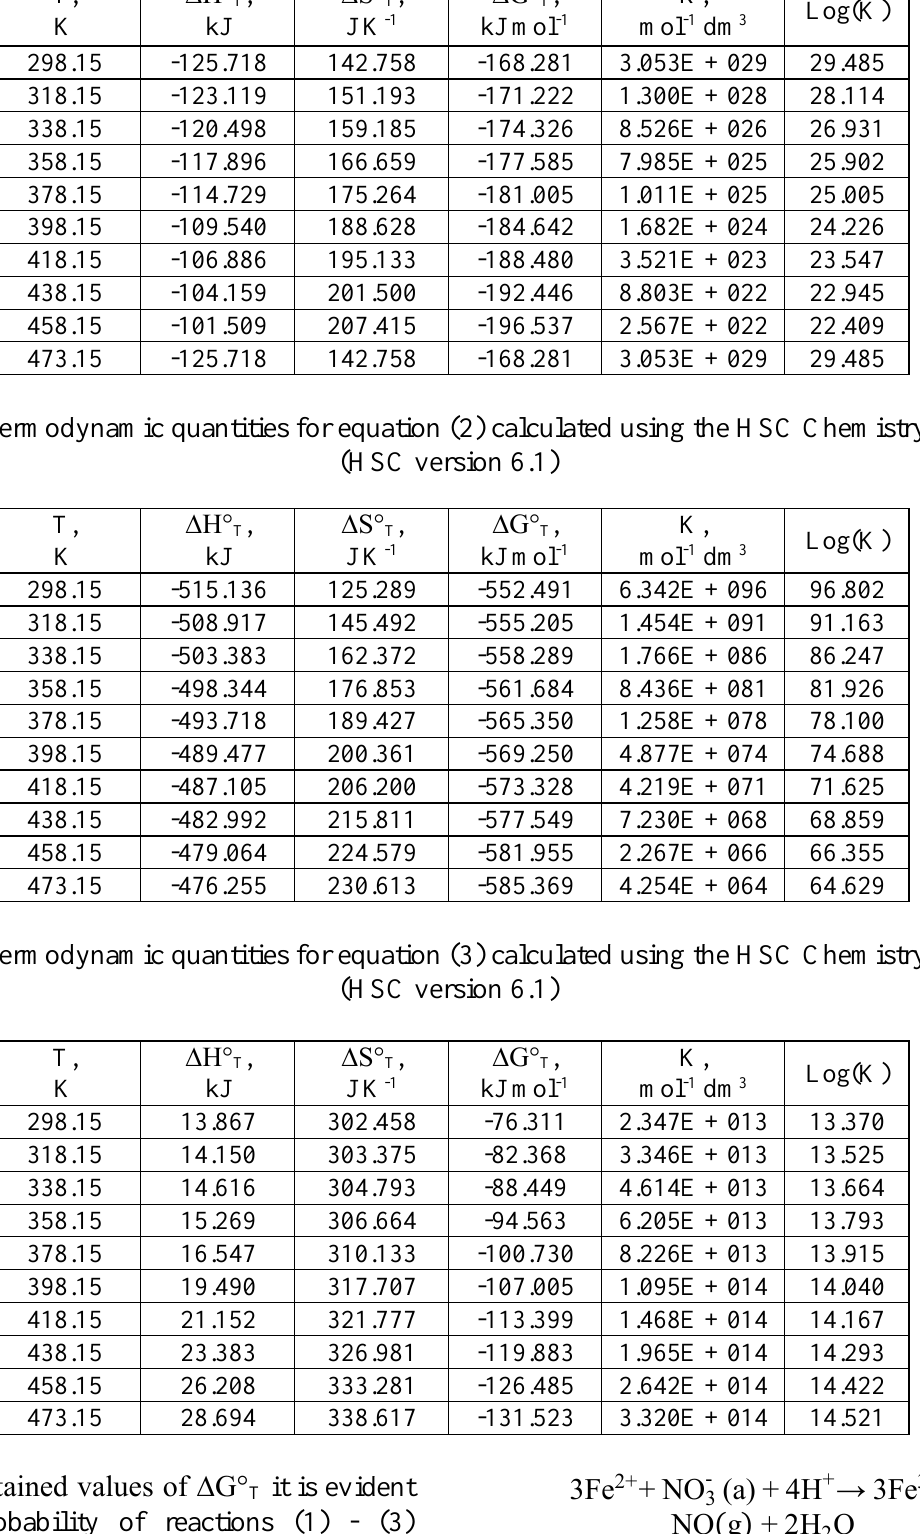
Table 1. Thermodynamic quantities for equation (1) calculated using the HSC Chemistry program (HSC version 6.1)